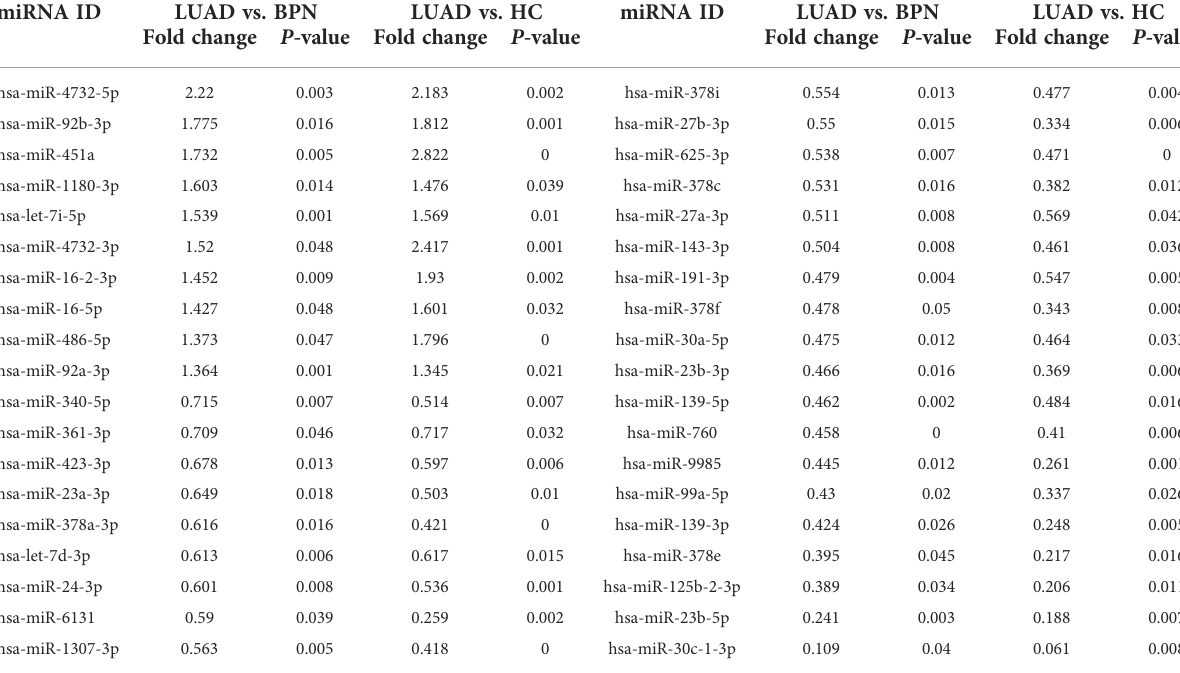
TABLE 2 Overlapping differentially expressed miRNAs (DEmiRs) between DEmiRs ( P < 0.05, LUAD vs . BPN) and DEmiRs ( P < 0.05, LUAD vs . HC). miRNA ID LUAD vs. BPN LUAD vs. HC miRNA ID LUAD vs. BPN LUAD vs. HC Fold change P -value Fold change P -value Fold change P -value Fold change P